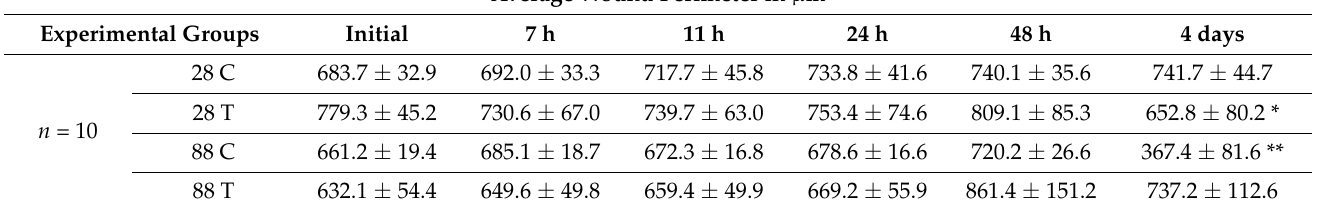
Table 2. Average wound perimeter ± SEM in µm for dermal fibroblasts of 28- and 88-year-old donors. C= Control Group and T= Training Group. (* p < 0.05, significance compared to initial; ** p < 0.01, significance compared to initial) .